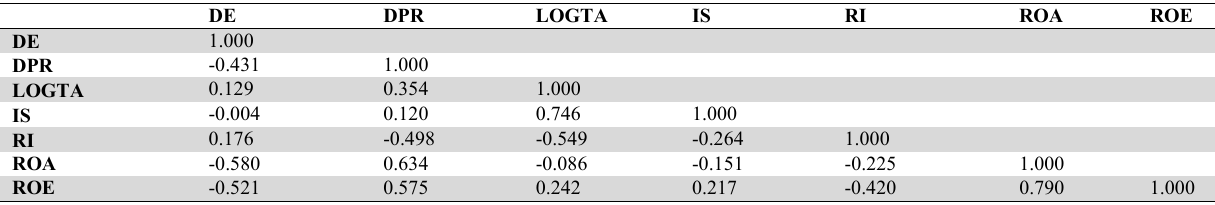
Correlation matrix